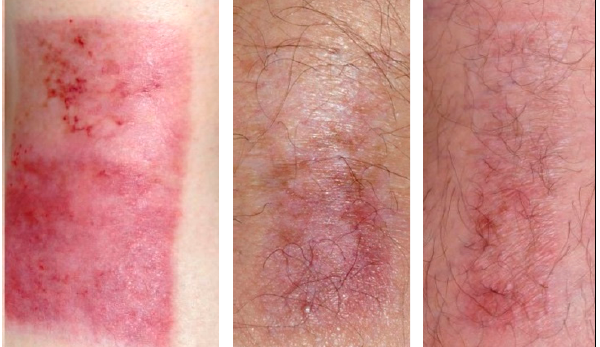
Figure 2. Skin graft wound, separated in two halves, treated with TBG at the upper half and standard of care at the lower half, left photo showing situation of healing 14 days postoperatively, middle photo showing situation of healing 3 months postoperatively, and right photo showing situation of healing 12 months postoperatively [27].